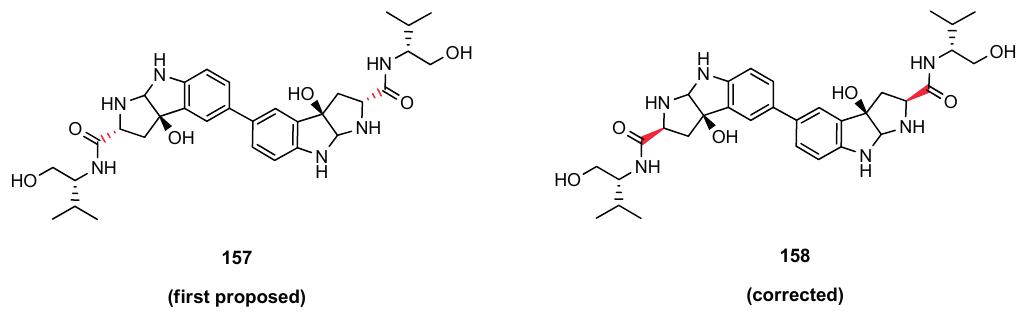
Figure 16. Proposed ( 157 ) and proven ( 158 ) structure of the central himastatin degradation